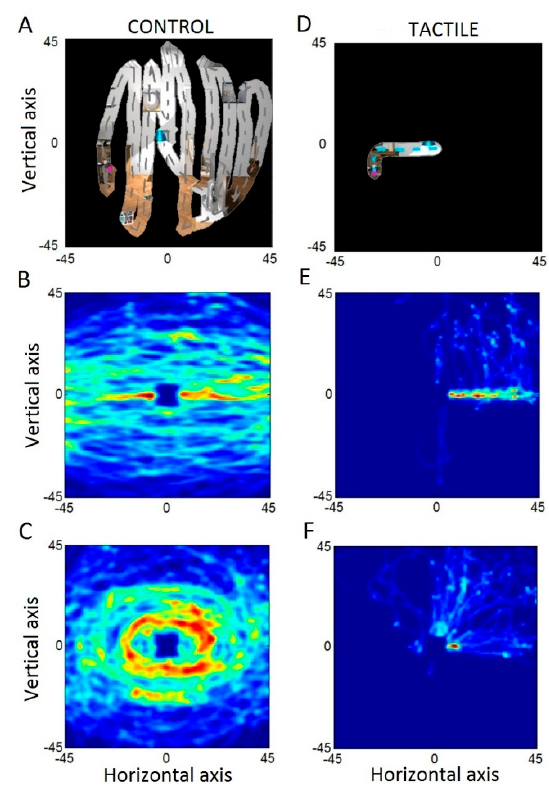
Figure 5. Examples of head movements observed during the visual search period in the control ( A – C ) and tactile conditions ( D – F ). Targets coordinates were transformed into positive values for each trial. A —Vertical scanning movement pattern. B —Density map of a search pattern on the horizontal axis mainly. C —Density map of a concentric circles search pattern. D —Ordered movements along the horizontal and then vertical axes, following the rendering of the two tactile cues. E —Density map of an ordered pattern starting on the horizontal axis. F —Density map showing an integrated pattern. Here, the subject is able to integrate the two coordinates before moving, and then performs oblique movements towards the target directly. In the density maps, target location, and head movement were normalized with a geometric transformation on the horizontal and vertical axes, placing every target location on the top right corner. Red indicates high densities and dark blue the absence of head positions. Each density map represents head movement for one subject.